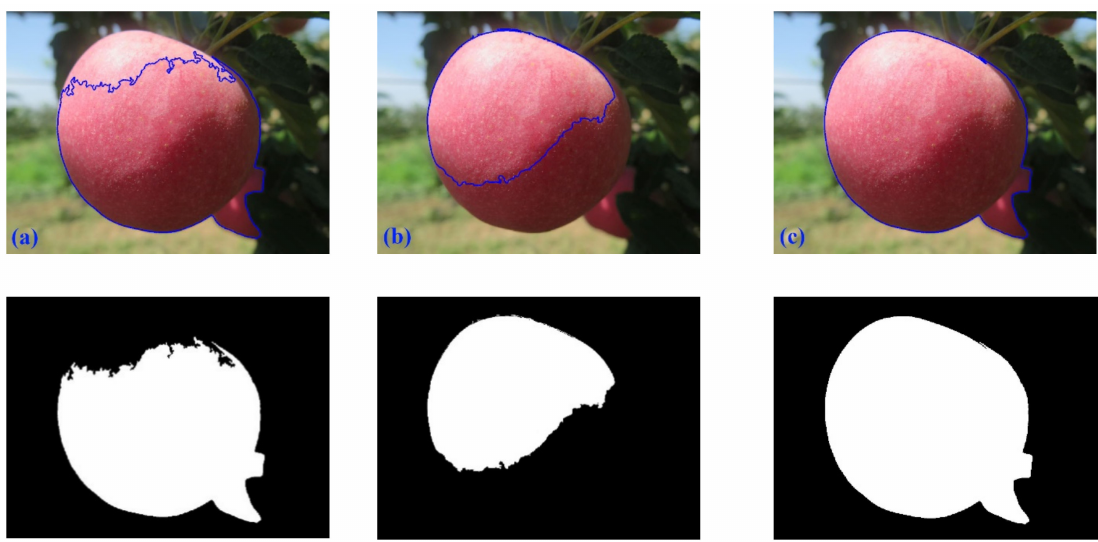
Figure 7. Fusion of shadow and halation segmentation results. ( a ) Shadow segmentation result, ( b ) Halation segmentation result, ( c ) Fusion of shadow and halation